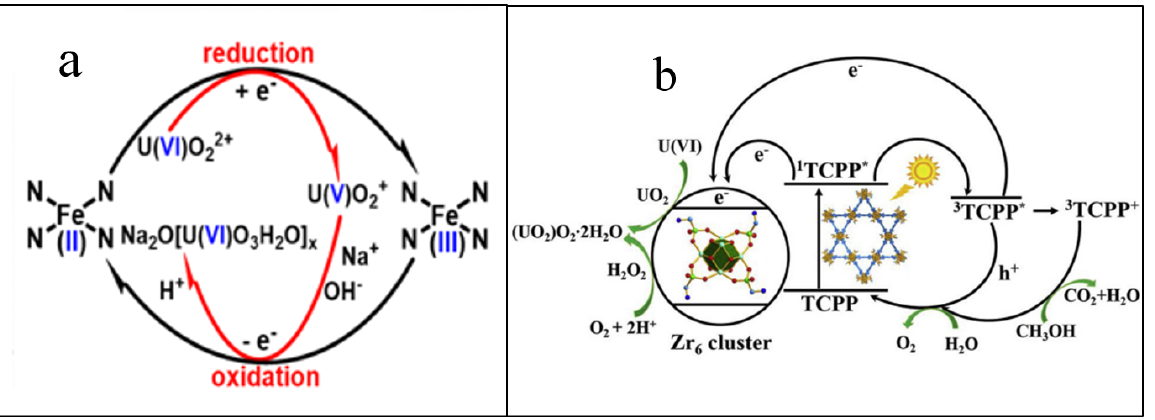
Figure 7. ( a ) Plausible electrocatalytic mechanism for Fe-N x -C-R-catalyzed extraction of U(VI) from seawater [46], Copyright 2021 John Wiley and Sons, ( b ) Schematic illustration of selective enrich- ment and photocatalytic reduction of U(VI) based on PN-PCN-222 [51], Copyright 2019